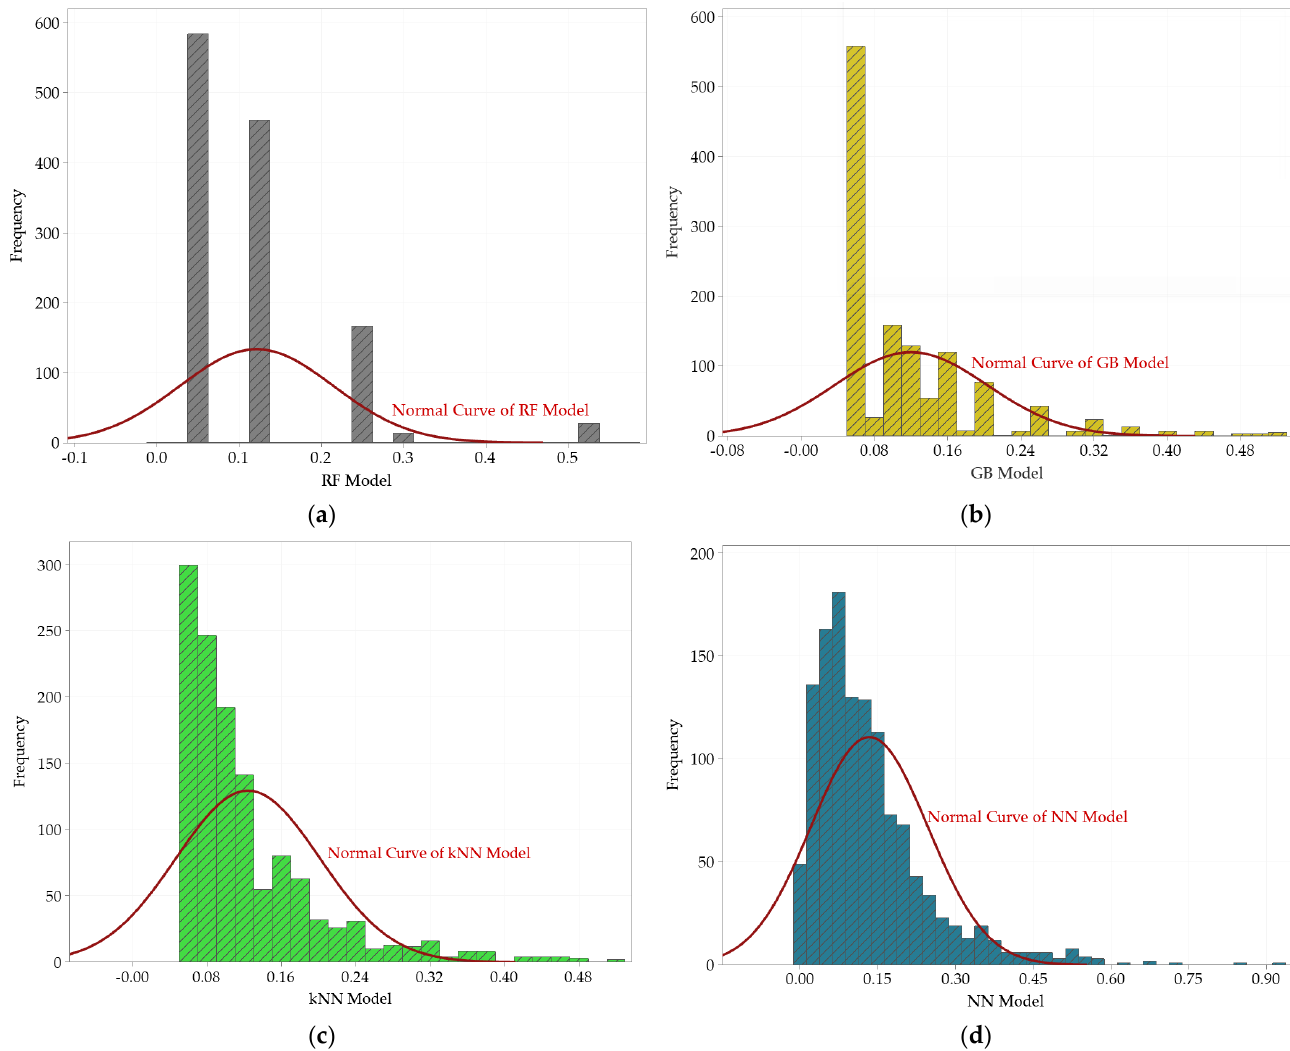
Figure 7. The comparison between actual and estimation data of delivery energy cost variable: ( a ) actual value vs. RF algorithm; ( b ) actual value vs. GB algorithm; ( c ) actual value vs. k NN algorithm; ( d ) actual value vs. NN algorithm.